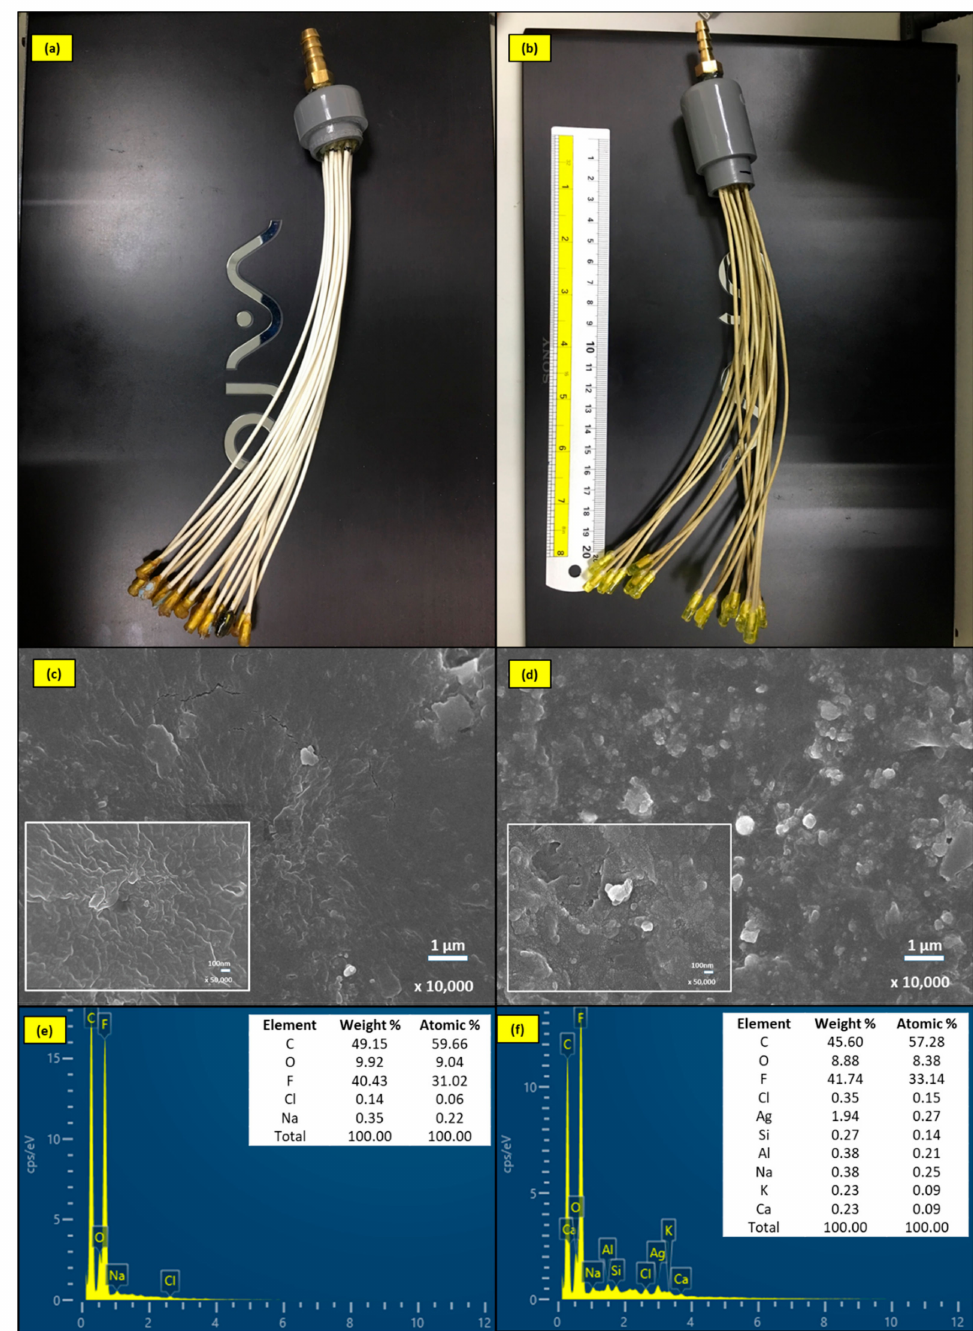
Figure 2. Pictorial representation of ( a ) the unmodified membrane and ( b ) the AgNPs-MF membrane; SEM image of ( c ) unmodified membrane, ( d ) AgNPs-MF membrane and EDS spectra of ( e ) unmodified membrane and ( f ) AgNPs-MF